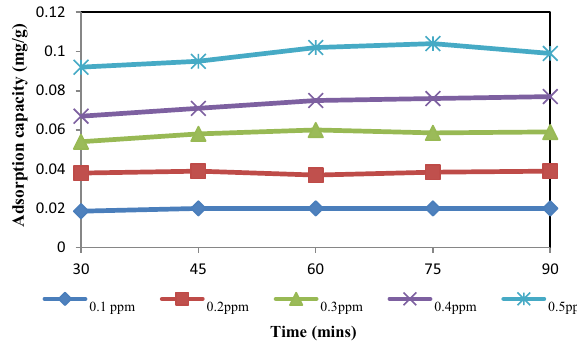
Fig. 1 Equilibrium time at varying initial arsenic concentration at a constant pH -7.0, temp 30 °C at 120